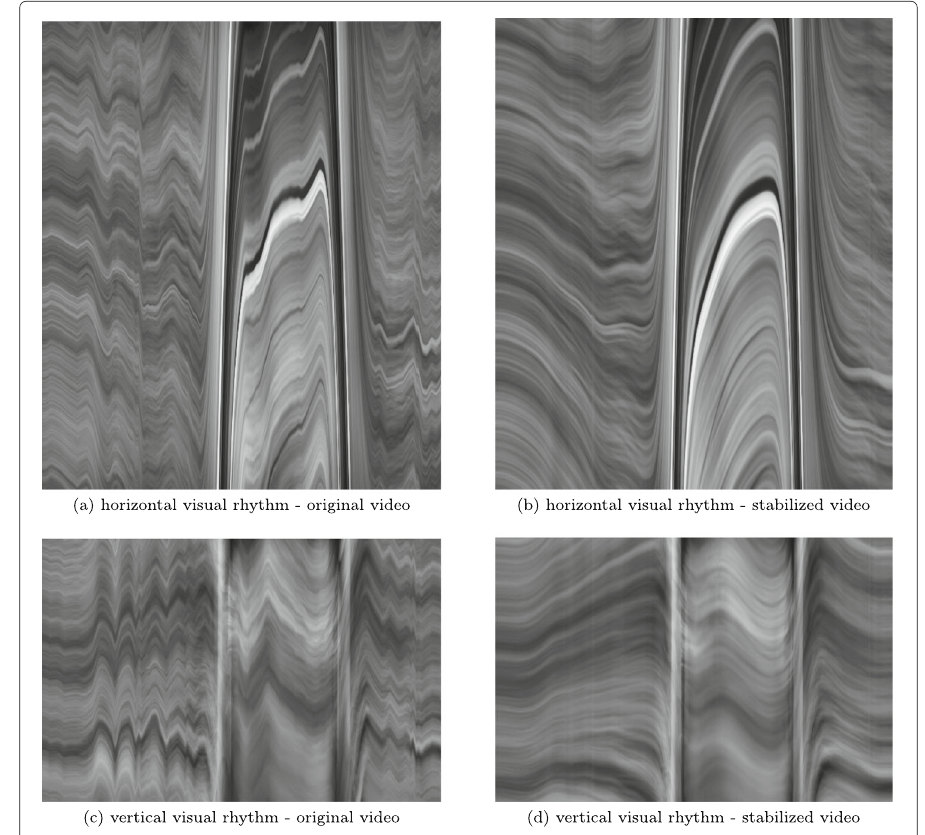
Fig. 14 Visual rhythms for video QuickRotation 0 . a Horizontal visual rhythm for original video. b Horizontal visual rhythm for stabilized video. c Vertical visual rhythm for original video. d Vertical visual rhythm for stabilized